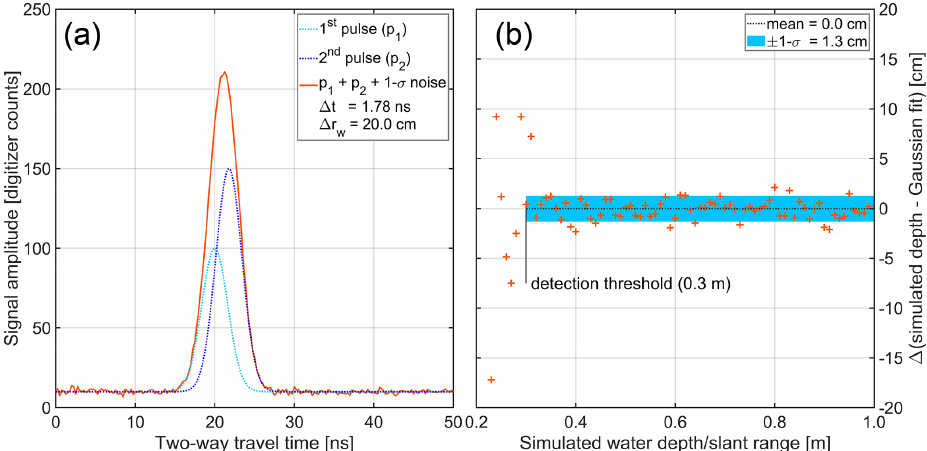
Figure B2. (a) Synthetic Gaussian waveforms of overlapping surface and bottom return pulses. The FWHM pulse width is 1.6ns (1 σ ), and the mean of the two pulses is separated by (cid:49)t = 1 . 78ns, which corresponds to a slant range (cid:49)r w = 20cm in water. The combined waveform has the average ATM T6 and T7 system noise level added. The two pulses are not discernible in the combined waveform. (b) Sensitivity analysis of the nonlinear regression. The mean of difference between the synthetic water depth and the 250000 nonlinear regressions for each water depth is shown (orange crosses), and the standard deviation (1 σ ) and mean for water depths greater than the determined detection threshold of 0.30m are